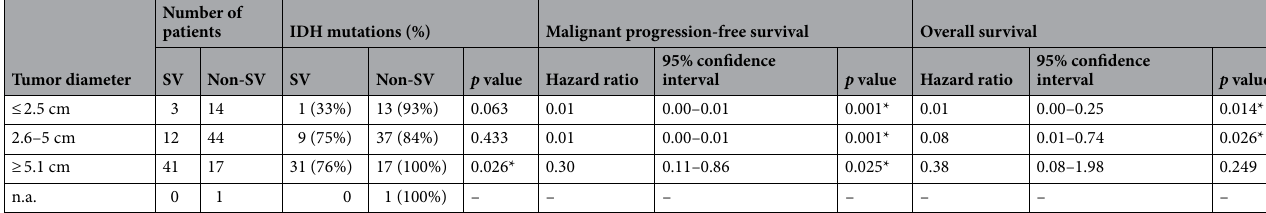
Table 3. Subventricular zone involvement as prognostic marker in glioma WHO grade 2 with biopsy only. Univariate malignant progression-free and overall survival analysis for subventricular zone involvement as prognostic marker was performed among WHO grade 2 glioma patients (n = 132), which did not undergo surgical tumor resection but biopsy only. Patients were stratified for tumor size, and IDH mutation status is indicated. Hazard ratio, 95% confidence interval of hazard ratio, and p value are given. Outcome analyses (malignant progression-free survival, overall survival) were performed using Kaplan–Meier survival analysis and log-rank test. Asterisks indicate p ≤ 0.05. IDH isocitrate dehydrogenase 1/2, n.a. not available for review, non-SV non-subventricular, SV subventricular, –